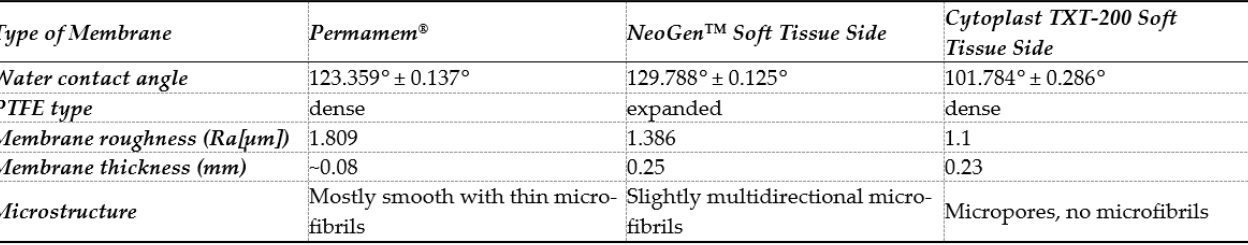
Figure 2. Material characterization of non-resorbable polytetrafluoroethylene (PTFE) membranes. Permamem ® NeoGen TM soft tissue side Cytoplast TXT-200 soft tissue side